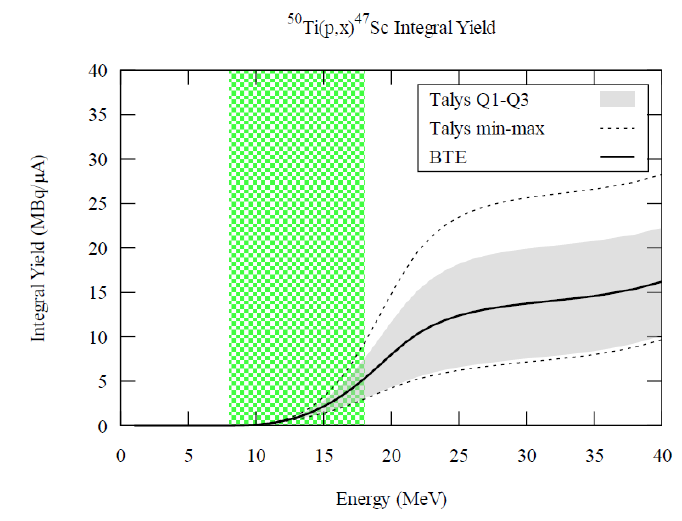
Fig. 6. Predicted yield for 47 Sc from 50 Ti. The yield has been calculated for a current I 0 = 1 μA and irradiation time T = 1h. The green area highlights the energy window (18-8 MeV) that optimizes the production of 47